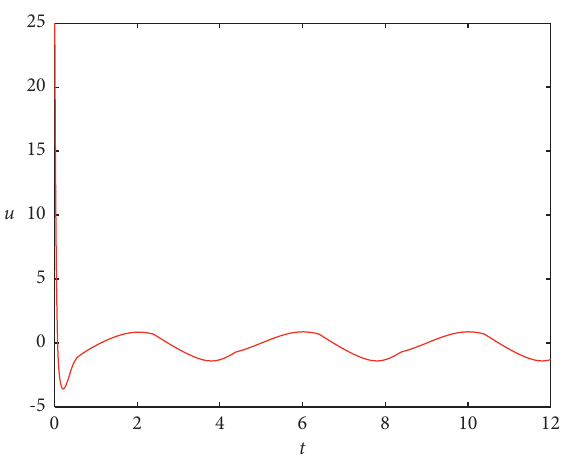
for Example 1. 2